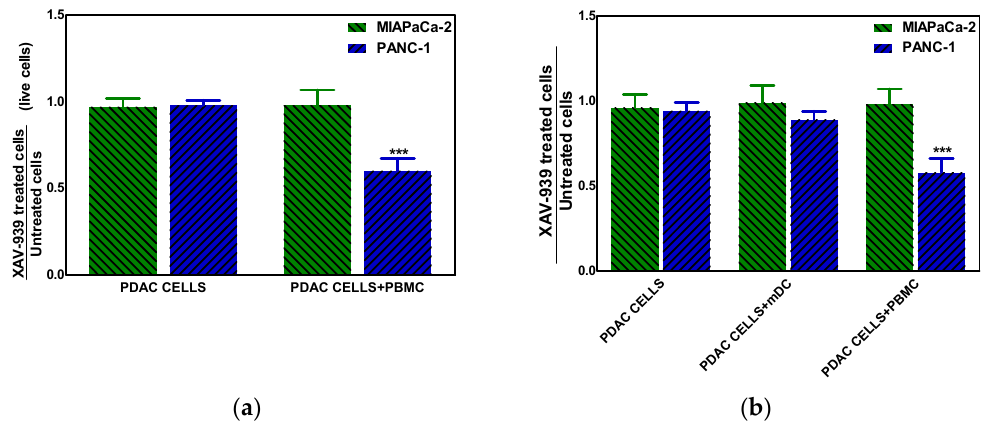
Figure 8. ( a ) Killing of PDAC cells in presence of 10 µM XAV-939 and PBMC. ( b ) Effect on cell proliferation by XAV-939 (10 µM) on PDAC cells in presence and absence of mDCs alone or PBMCs comprising mDCs. Results are expressed as fold change (*** p -value < 0.001 for PANC-1 treated cells vs. untreated ones).